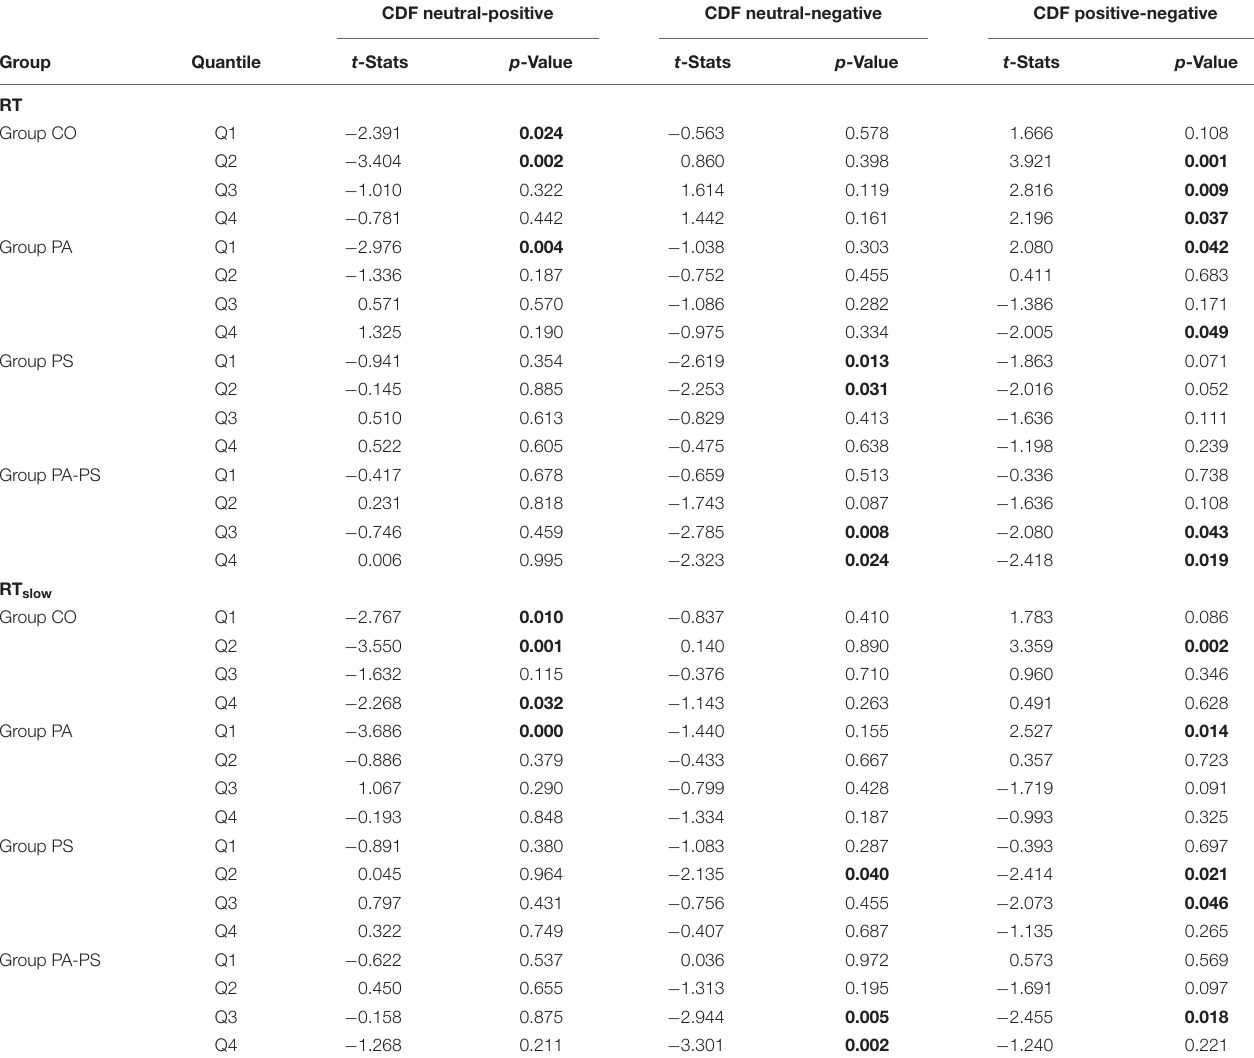
TABLE 3 | Delta plots (effect of